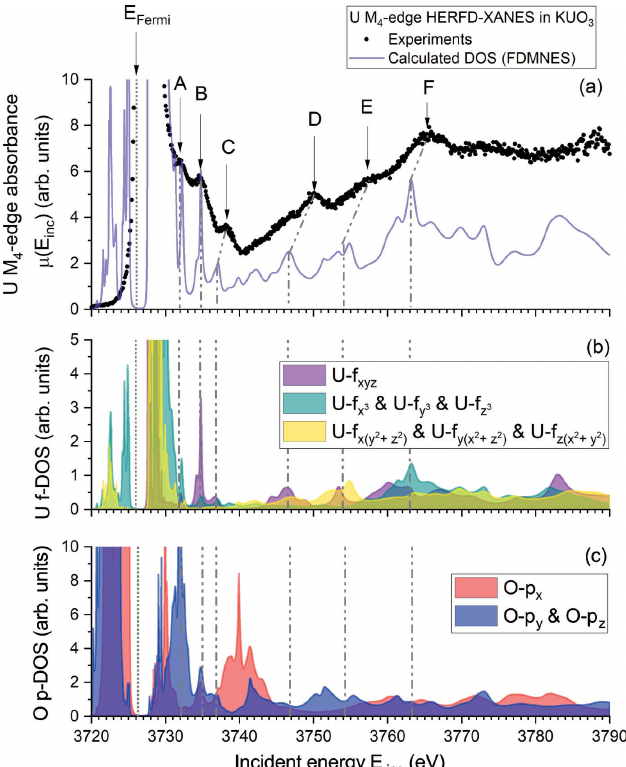
Figure 4 ( a ) Uranium M 4 -edge HERFD-XANES and the corresponding FDMNES calculated spectrum (non convoluted). The absorbance scale was limited in this plot to better distinguish the numerous satellite features (denoted as A, B, C, D, E and F). We refer to Figure 7 in the supporting information for the full scale absorption spectrum. ( b , c ) Calculated U- f and O- p partial DOS, here expressed as cubic harmonics, to allow direct comparison with the experimental XANES spectrum. The Fermi energy level is indicated with a vertical dotted line. Vertical dashed-dotted lines indicating the position of features A, B, C, D, E and F in partial DOS are also present to guide the eyes. We refer to Figure 6 of the supporting information for the other calculated partial